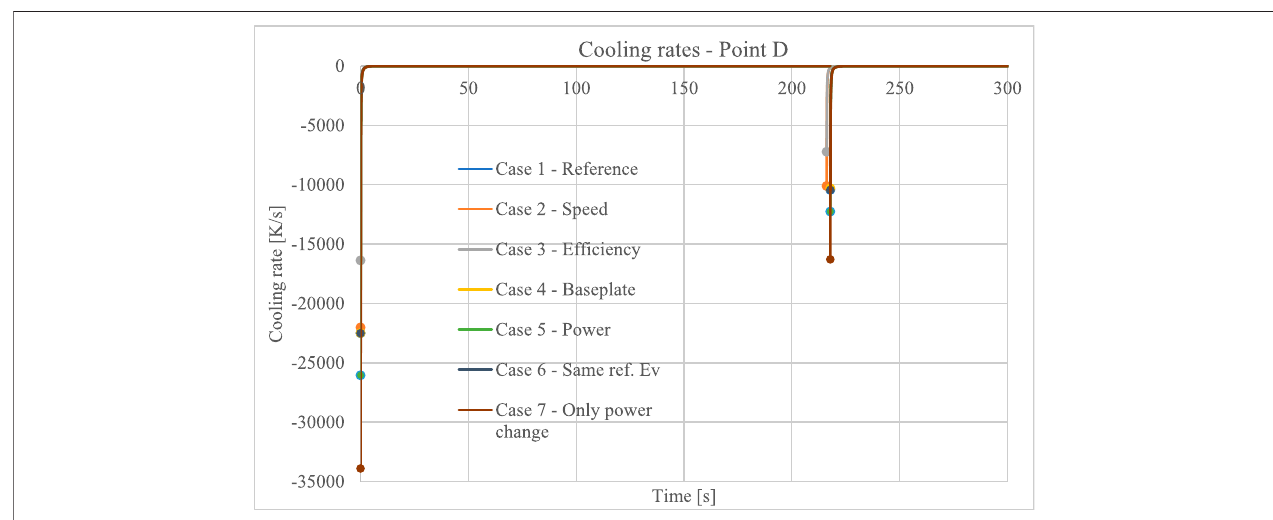
FIGURE 4 | Cooling rates at the bottom of point D using different sets of build